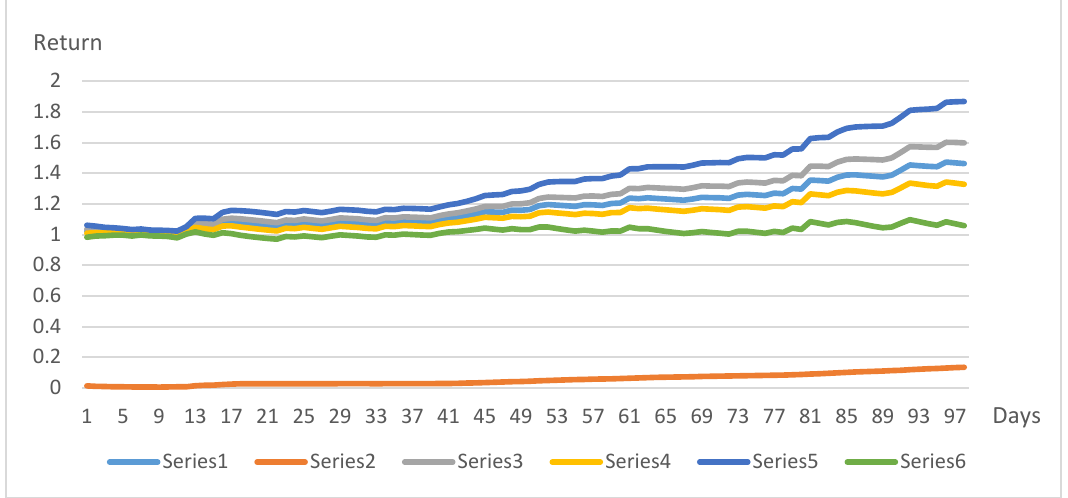
Figure 8. Confidence intervals of return on 30 stocks’ portfolio (German market) (source: compiled by the authors based on Yahoo Finance data and own calculations).